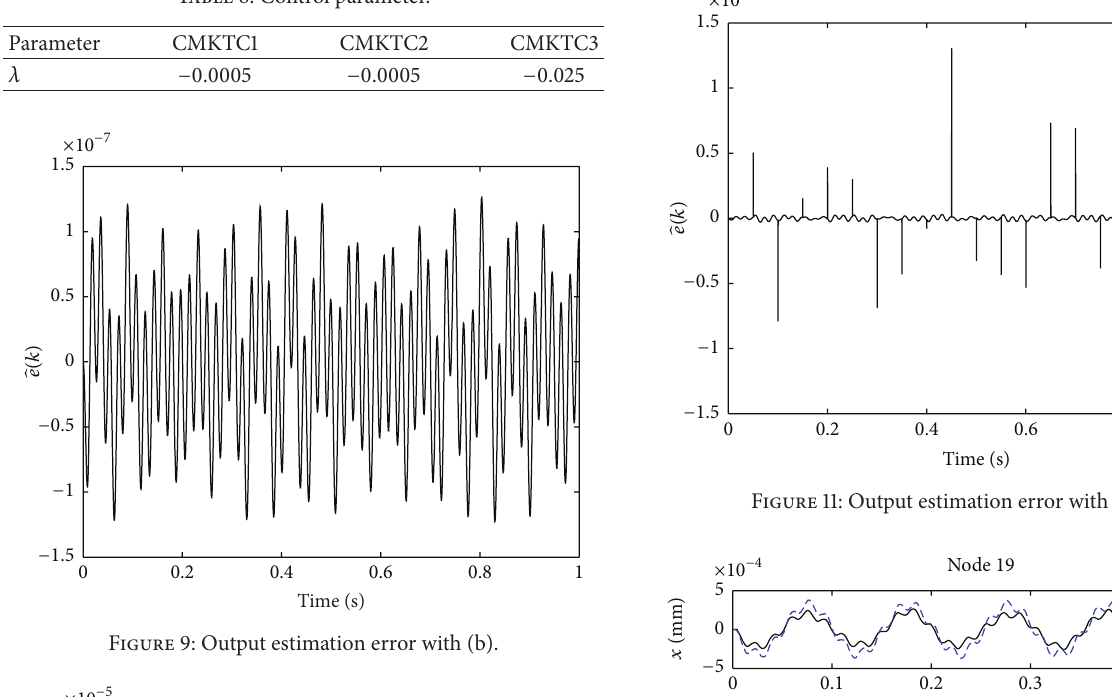
Table 8: Control parameter.